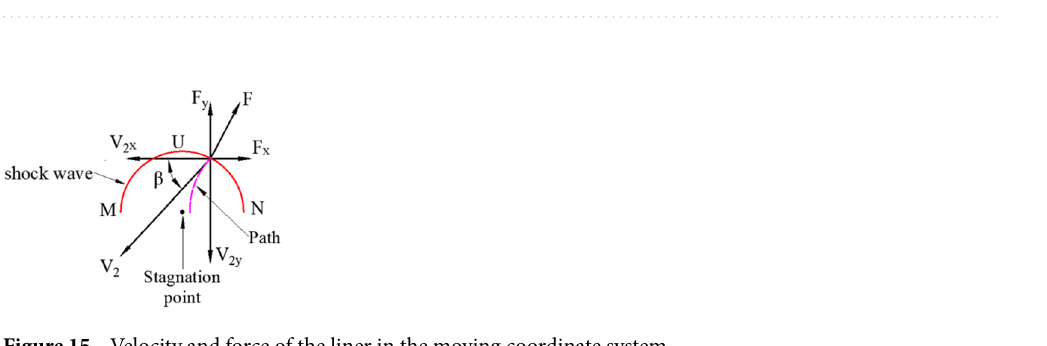
Figure 14. Schematic of the position of the liner and the jet.